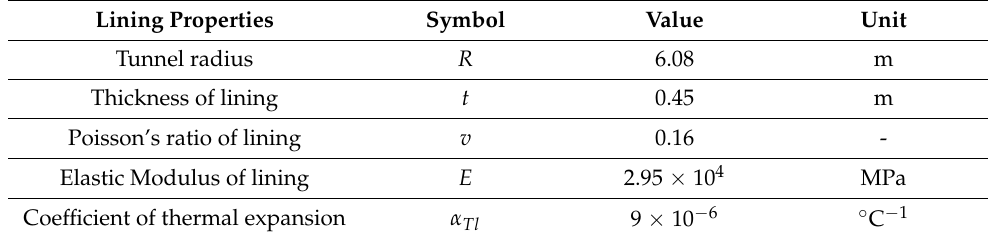
Table 1. Lining properties used in the